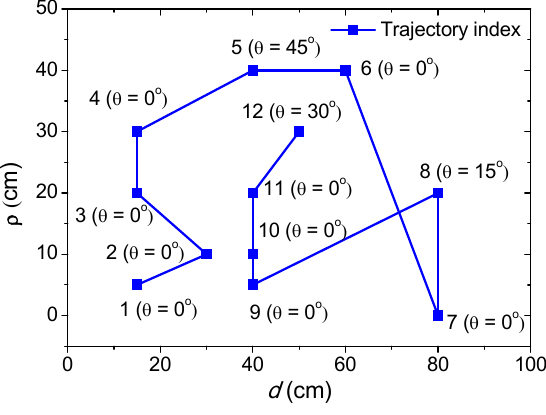
Figure 20. A sequence of test cases under changes of three geometric parameters.